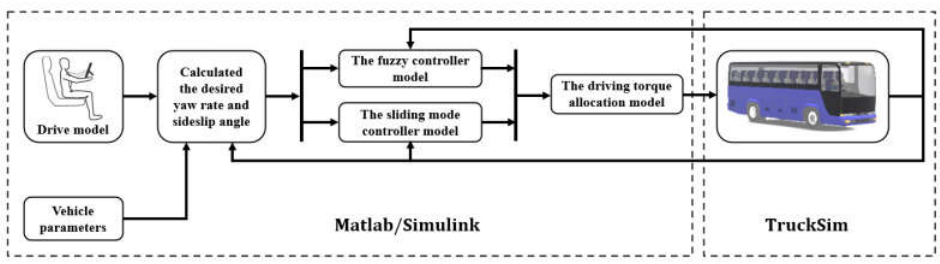
Figure 9. Matlab/Simulink–TruckSim co-simulation platform.